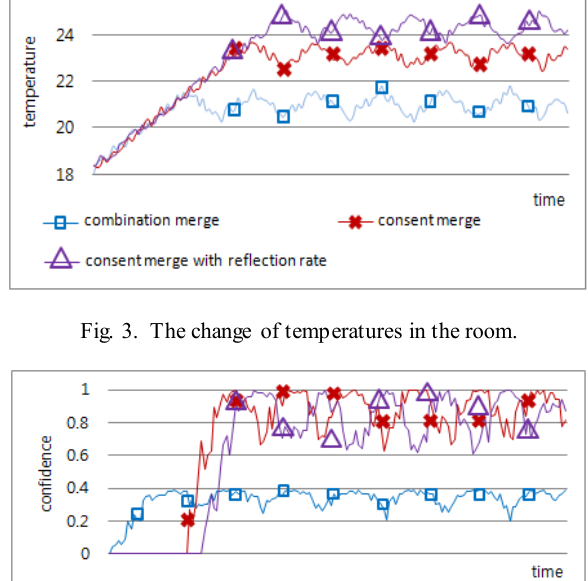
Fig. 5 represents the standard deviation of the confidences computed by the agents. Notice that the proposed schemes show relatively smaller standard deviation than combination merge, which implies that the service is provided to all the agents as fair as possible. The standard deviation of the confidence with reflection rate is higher than that without it. This indicates that reflection rate increases the confidence of specific agents, which provides exclusive rational